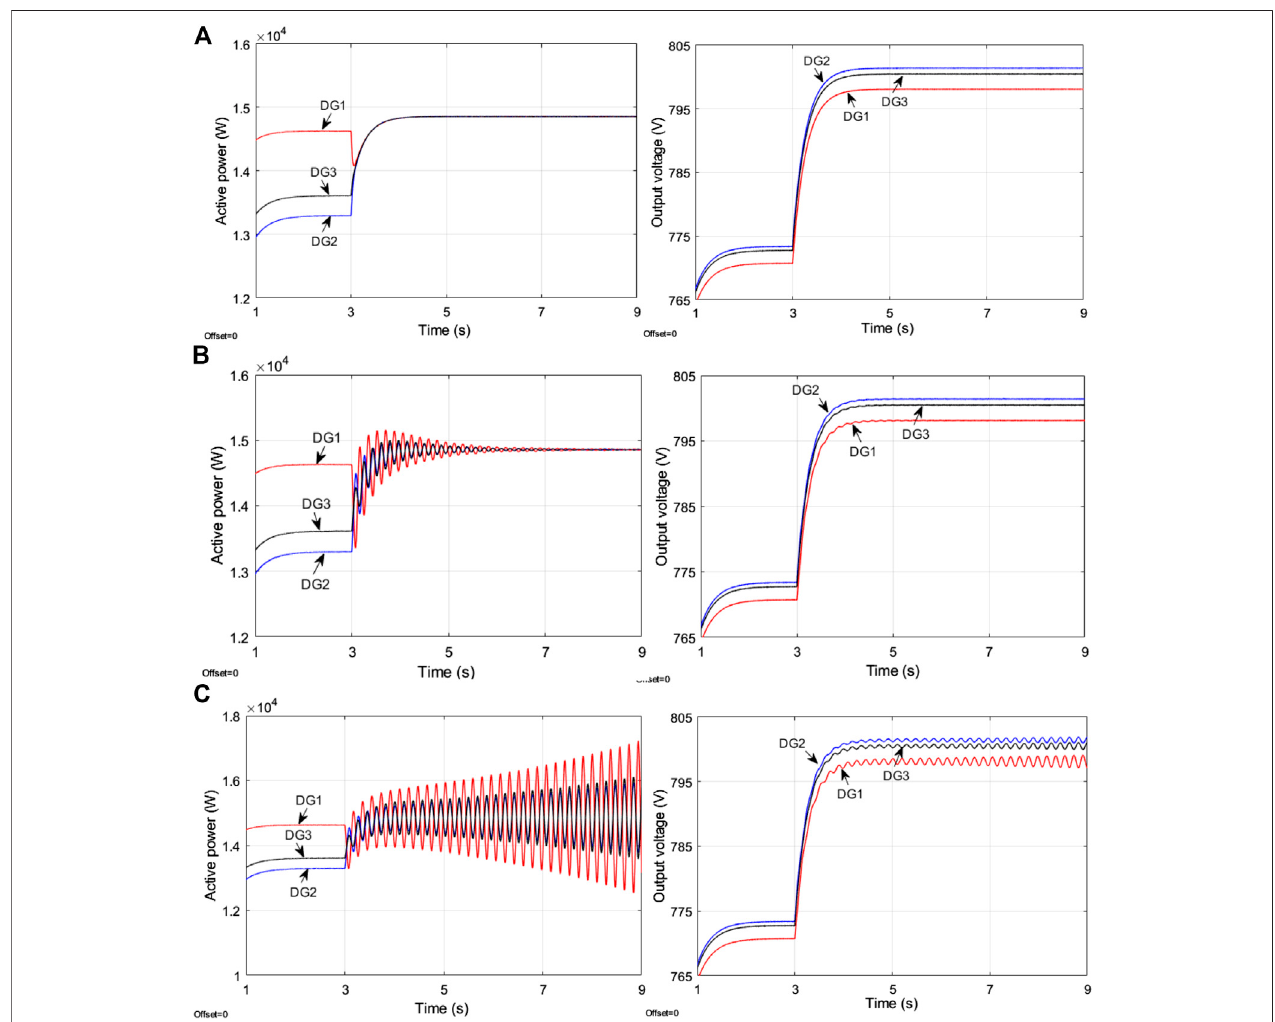
FIGURE 9 | Simulation results of active powers and actual output voltages with various time delays under k i 1 (cid:1) 16, k i 2 (cid:1) 4 (A) Without delay (B) τ (cid:1) 55 ms (C) τ (cid:1) 65 ms.